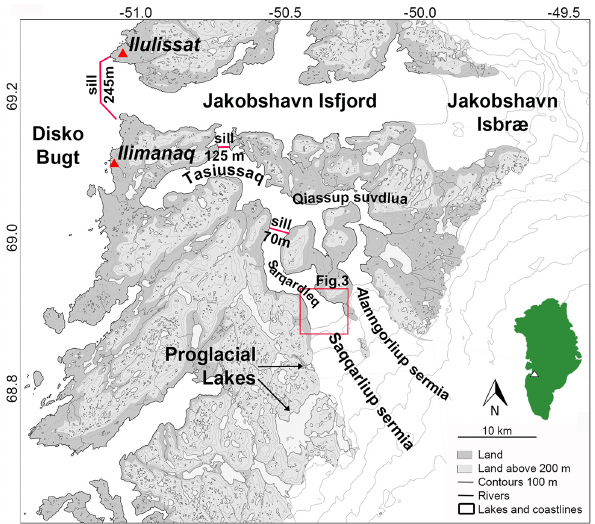
Figure 1. The Sarqardleq Fjord–Saqqarliup sermia outlet glacier system in West Greenland. Modified from NunaGIS 1:100000 map (Asiaq, Greenland Survey). Sill locations shown in red. Figure 3 location shown in red